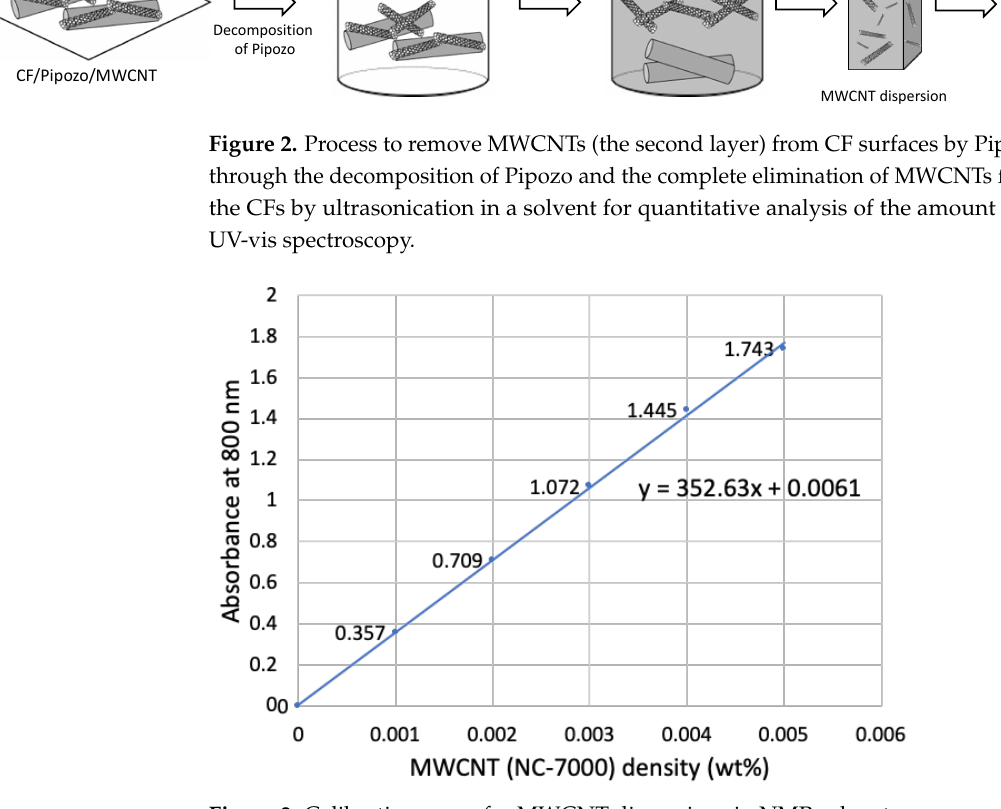
Figure 3. Calibration curve for MWCNT dispersions in NMP solvent.